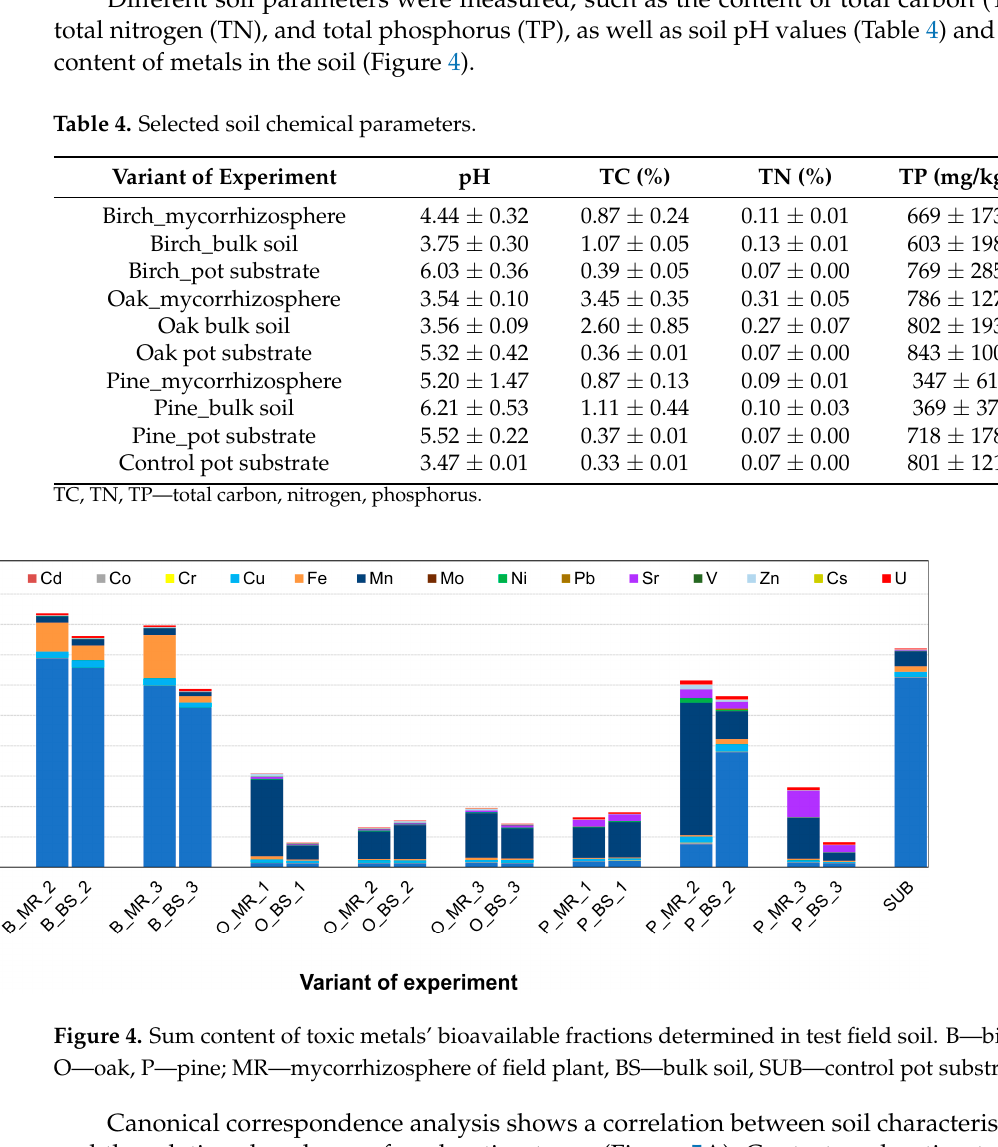
Figure 5. Canonical correspondence analysis biplot representing the correlation ( A ) between soil parameters and exploration types of mycorrhizae and ( B ) between soil parameters and mycorrhizal taxa described for field plants. CT—contact exploration type, ST—short-distance exploration type, MT—medium-distance exploration type, LT—long-distance exploration type.